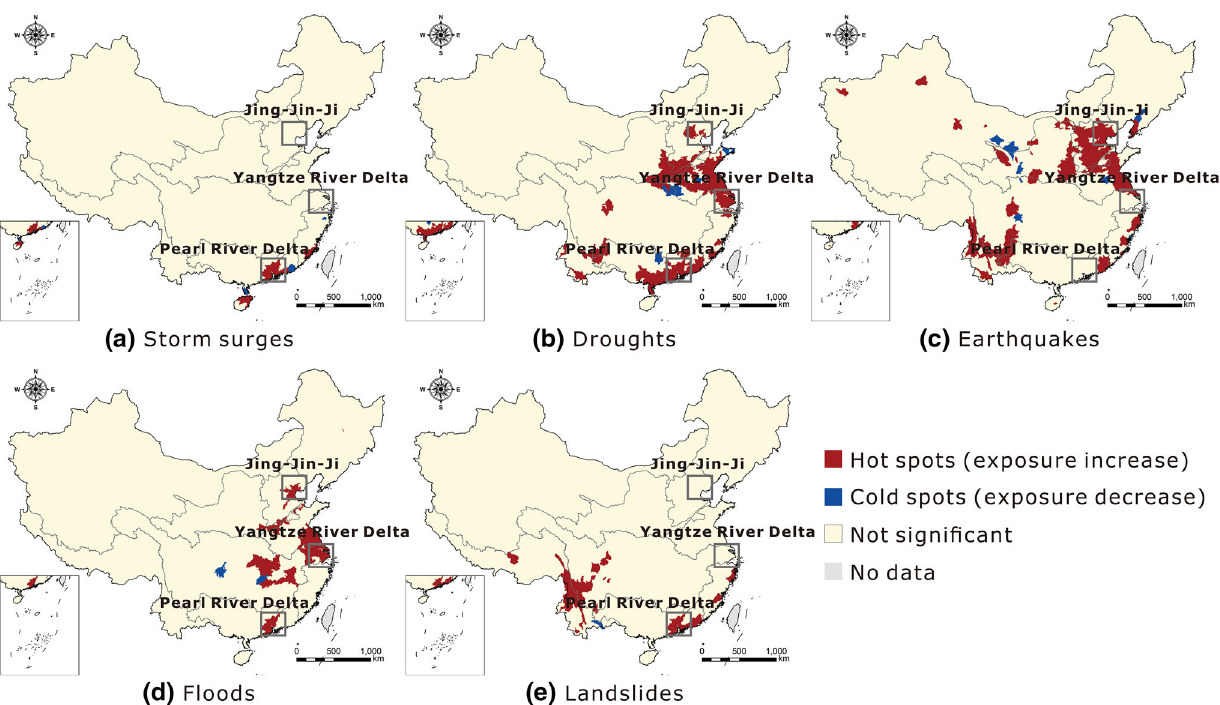
Fig. 3 Hot/cold spots of changes in population exposure to hazards in China from 1995 to 2005. Jing-Jin-Ji: Beijing–Tianjin–Hebei region